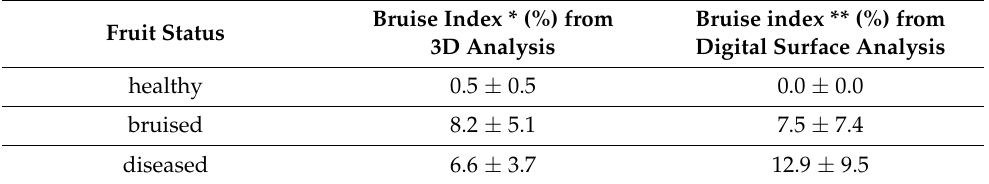
Table 6. Fruit bruise index with different methods. Values shown are mean ± standard deviation. Fruit